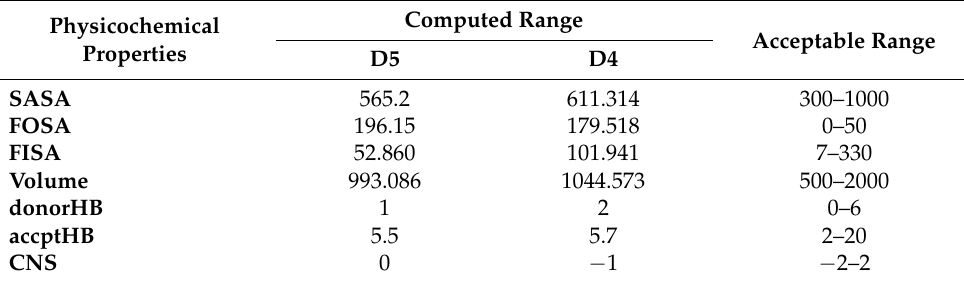
Table 2. The computed physicochemical properties of D5 using the Qikprop approach of Schrodinger suite 2018.